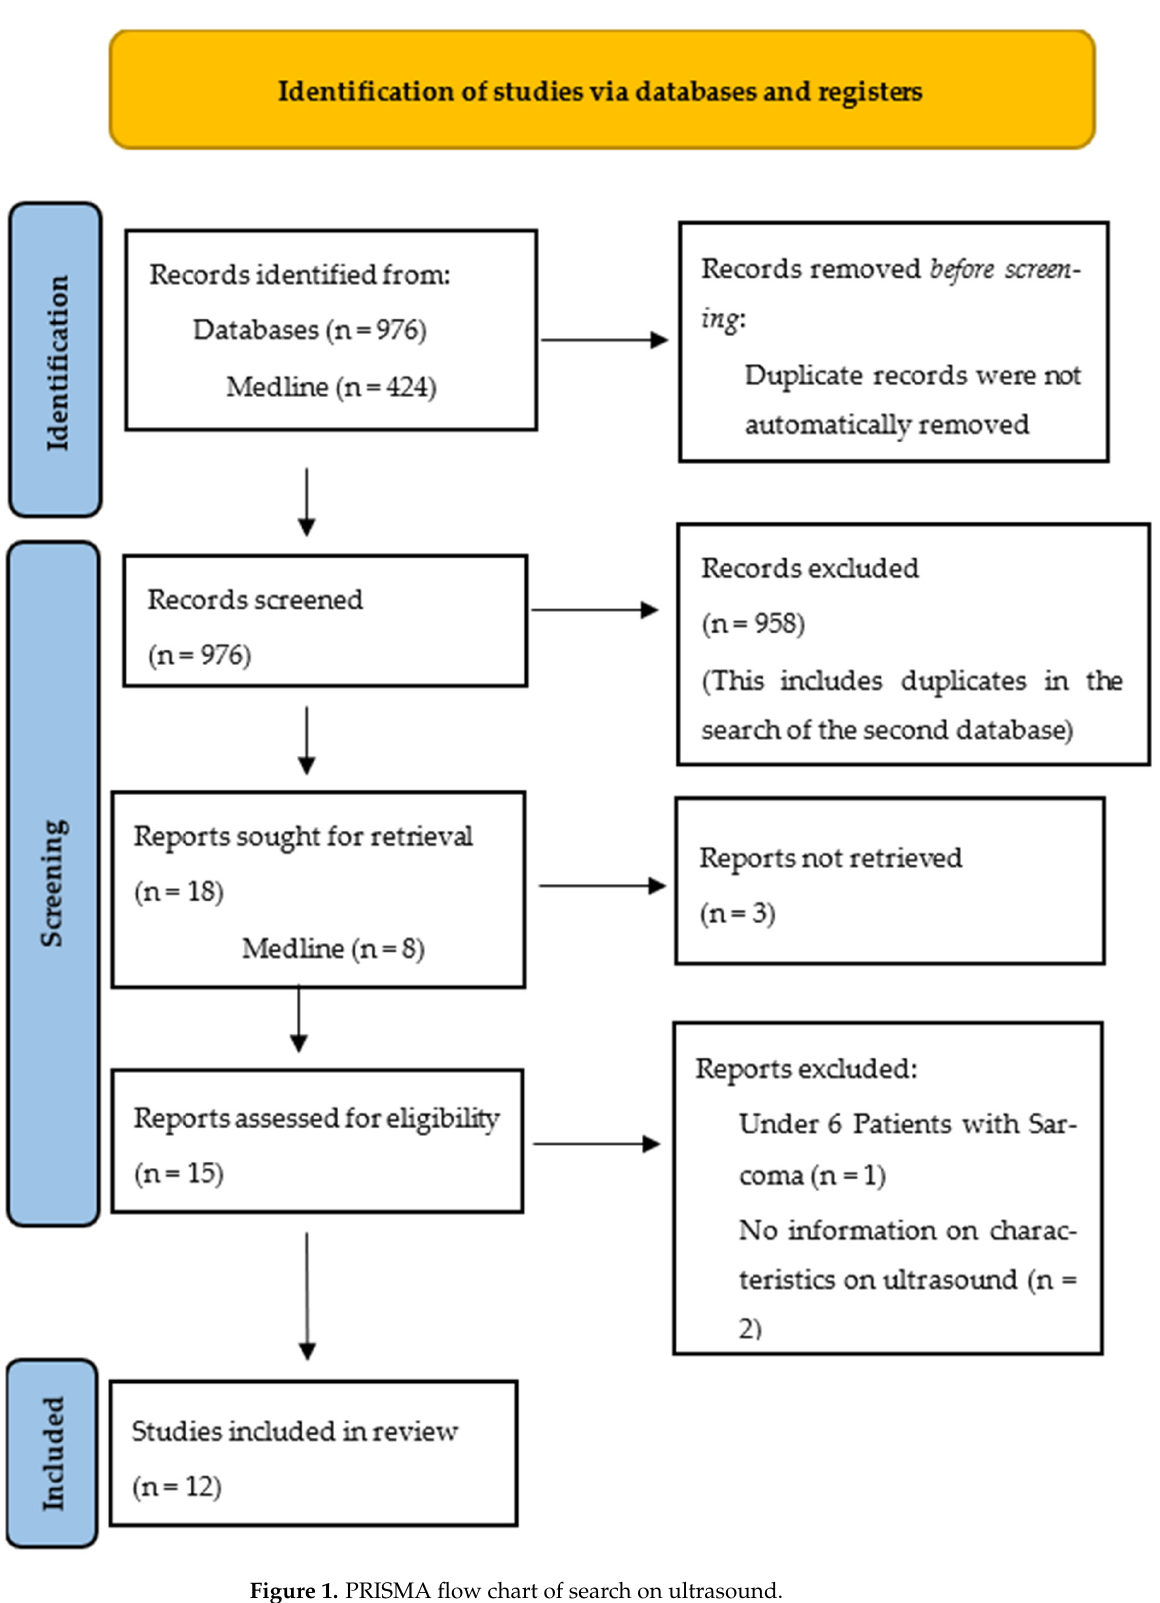
Figure 1. PRISMA flow chart of search on ultrasound.